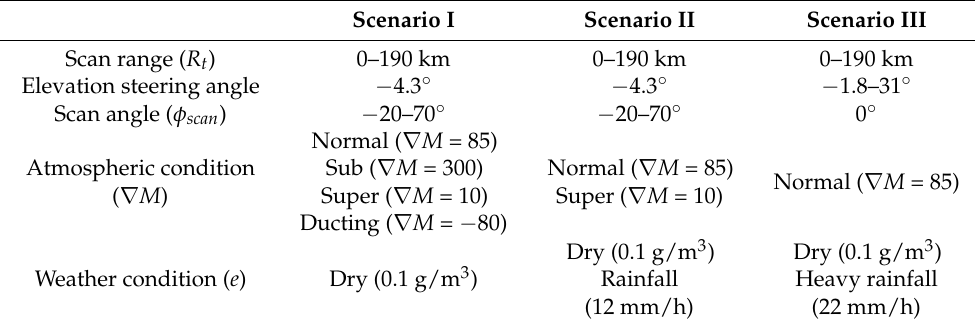
Table 2. TDP simulation scenarios.